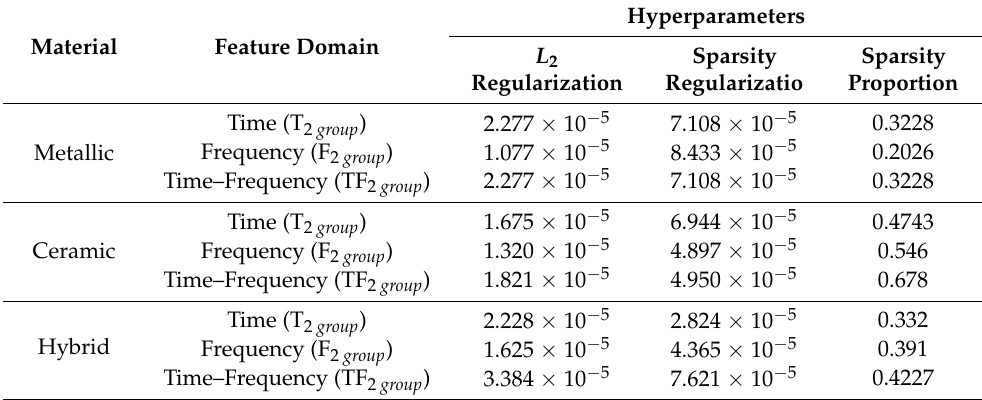
Table 5. Parameters tuned by the GA for each SAE structure that is considered for each domain of analysis for the stator current signature used in the stacked AE; all technology materials.